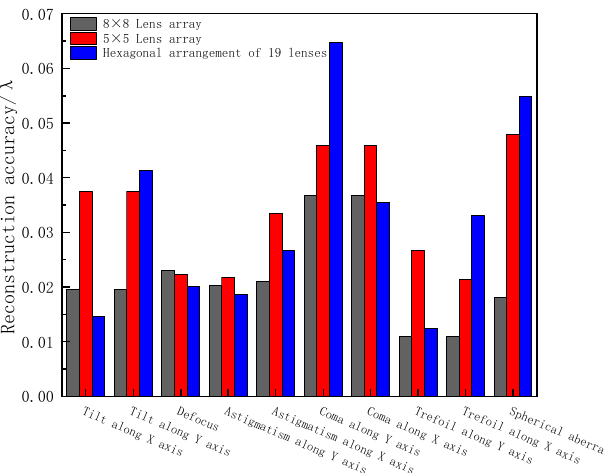
Figure 4. Reconstruction accuracy of a single aberration by three arrangement methods.